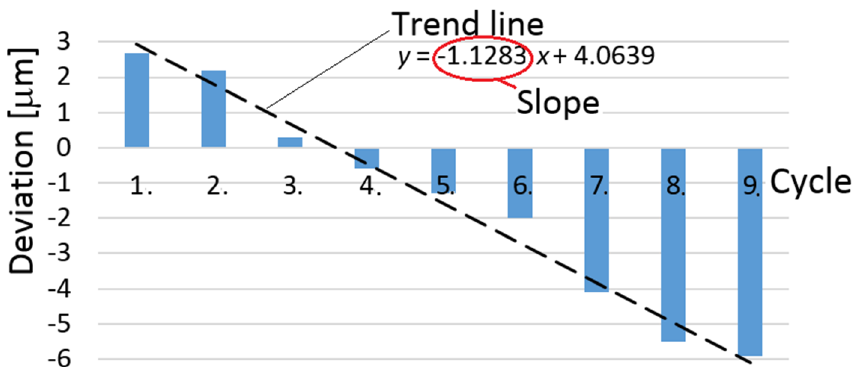
Figure 9. Gradual thermal shift of the first position during 9 load-free cycles. The trend line equation determines the direction.